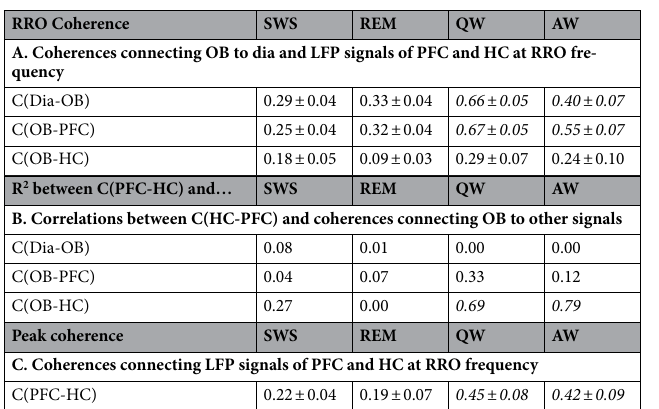
Table 1. Relationship between coherences through OB and their effect on RRO synchronization between PFC and HC. Italic highlights relatively high coherences, above 0.4, and significant correlations (p < 0.05), R 2 , between pairwise coherences. C(X–Y): coherence between X and Y.